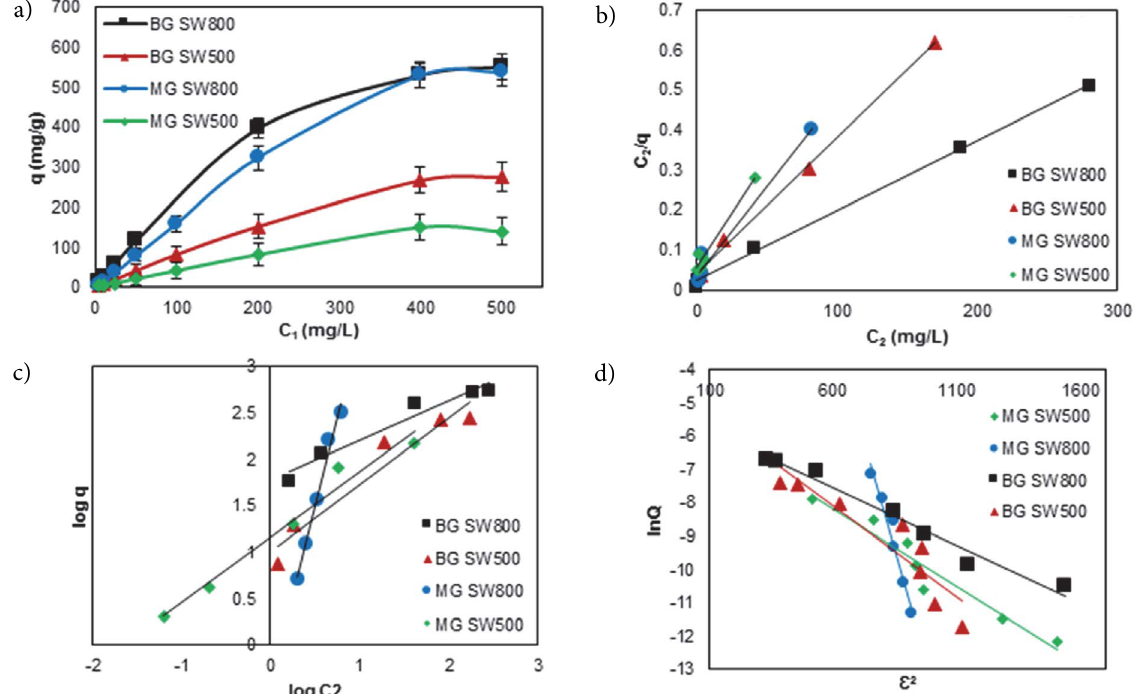
Figure 8. Adsorbed amount of dye as a function of initial concentration (a), Langmuir isotherms (b), Freundlich isotherms (c) and DR isotherms (d) for adsorption BG and MG, (initial dye concentration range 5–500 mg/L, volume 25 mL, adsorbent dose of BG and MG: 0.6 and 0.4 g/L for SW800 and, 1.2 and 2.4 g/L for SW500, contact time 24 h, n = 3) Table 2 . The isotherm parameters of Langmuir, Freundlich, and DR isotherms for BG and MG adsorption using SW500 and SW800 (n = 3). Brilliant Green Malachite Green SW800 SW500 SW800 SW500 Langmuir Isotherm Q max